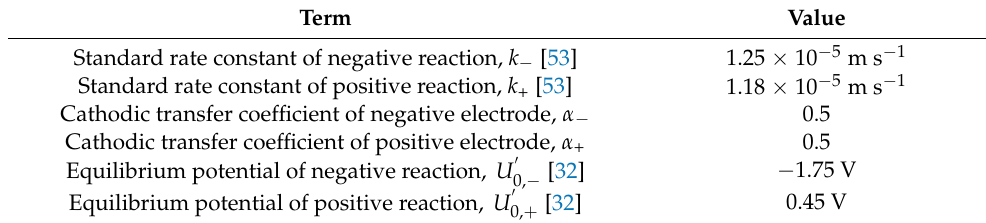
Table 4. Kinetic parameters.